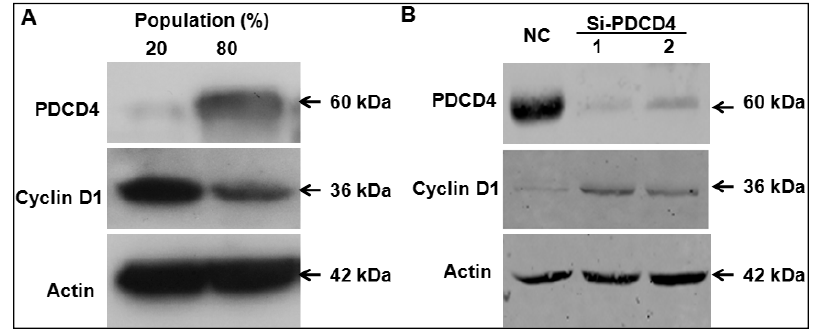
Figure 4. Knockdown of PDCD4 induces cyclin D1 expression in HaCaT cells. ( A ) Cyclin D1 expression was reduced in higher HaCaT cell density along with induction of PDCD4; ( B ) The protein level of cyclin D1 in PDCD4 silencing confluent cells were examined using Western blot. NC, negative control siRNA.